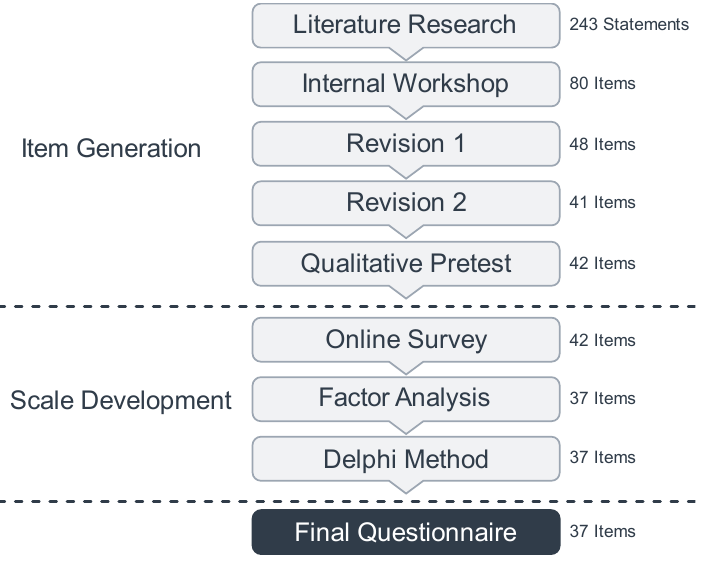
Figure 4. Overview of the methods during the development of the final questionnaire with resulting number of items per step.